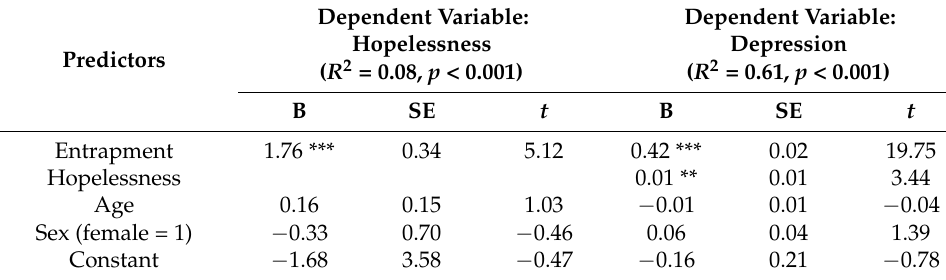
Table 2. Results of mediation analysis ( N = 367).